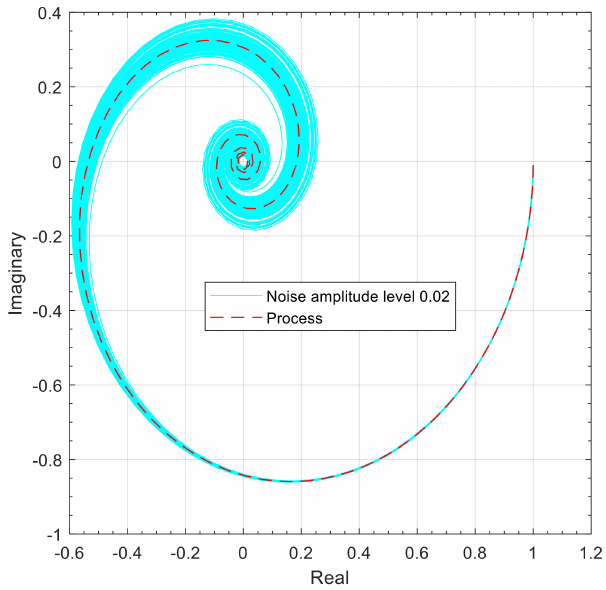
Figure 28. The Nyquist plots for process G P7